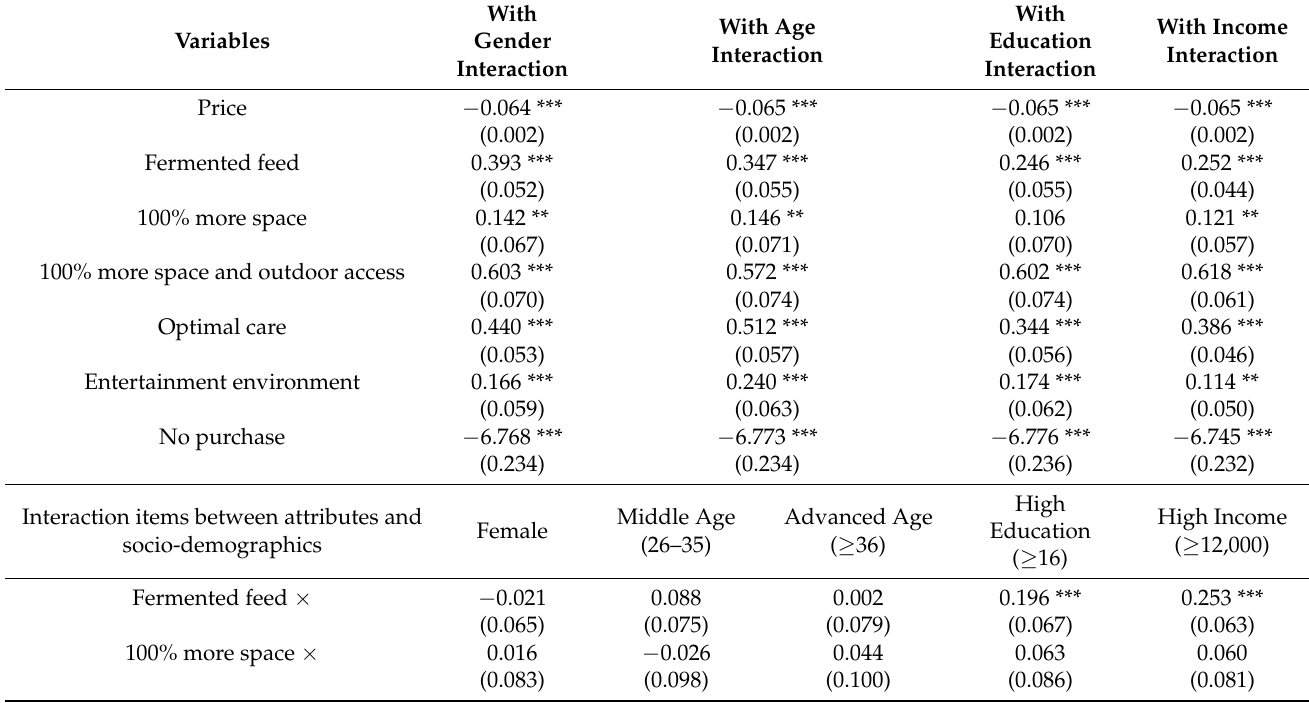
Table 4. Random parameter logit results with socio-demographics interaction